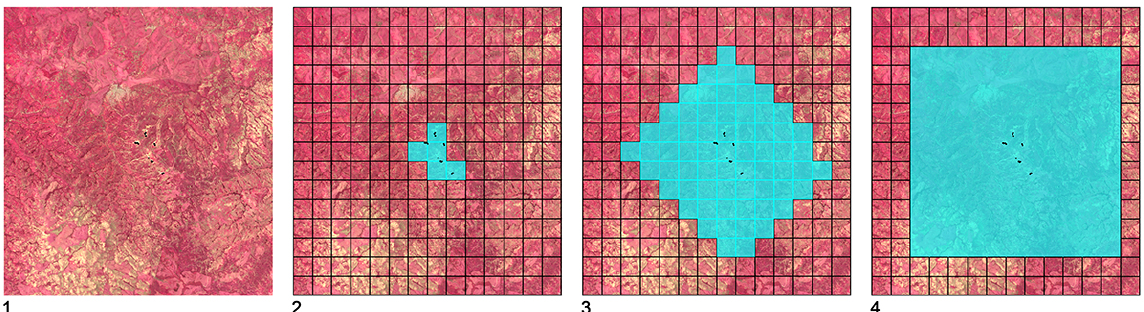
Figure 6. Screening of large survey extents: (1) Identification of seed points; (2) rectangular grid; (3) region growing; (4) ROI for VHR